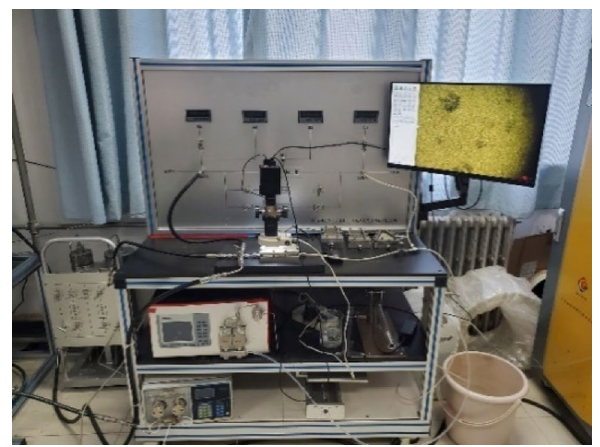
Fig. 1 General view of the visualization system for the microscopic process of sand production